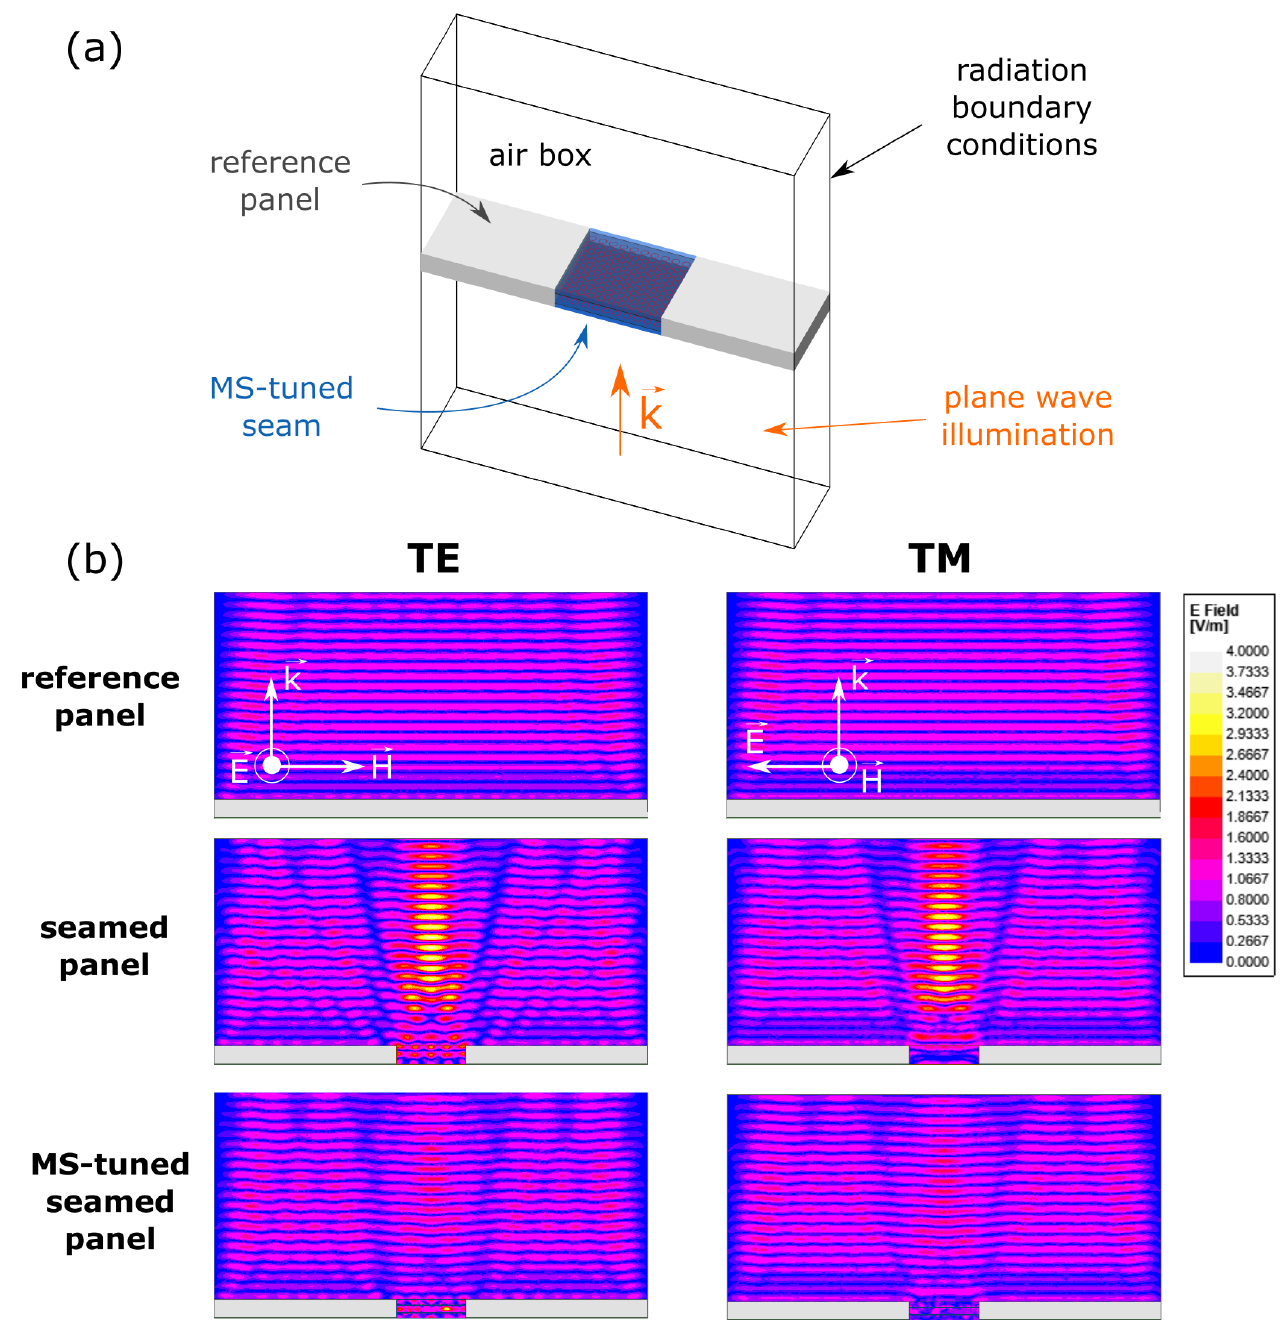
Figure 3. Numerical validation of the camouflaging effect. ( a ) Simulation setup, where a plane wave is used to illuminate the structure. ( b ) Scattered field distributions in the case of normally incident TE- and TM-polarized plane waves illuminating the reference panel ( first row ), the non-tuned seamed panel ( second row ) and the MS-tuned seamed panel ( third row ).